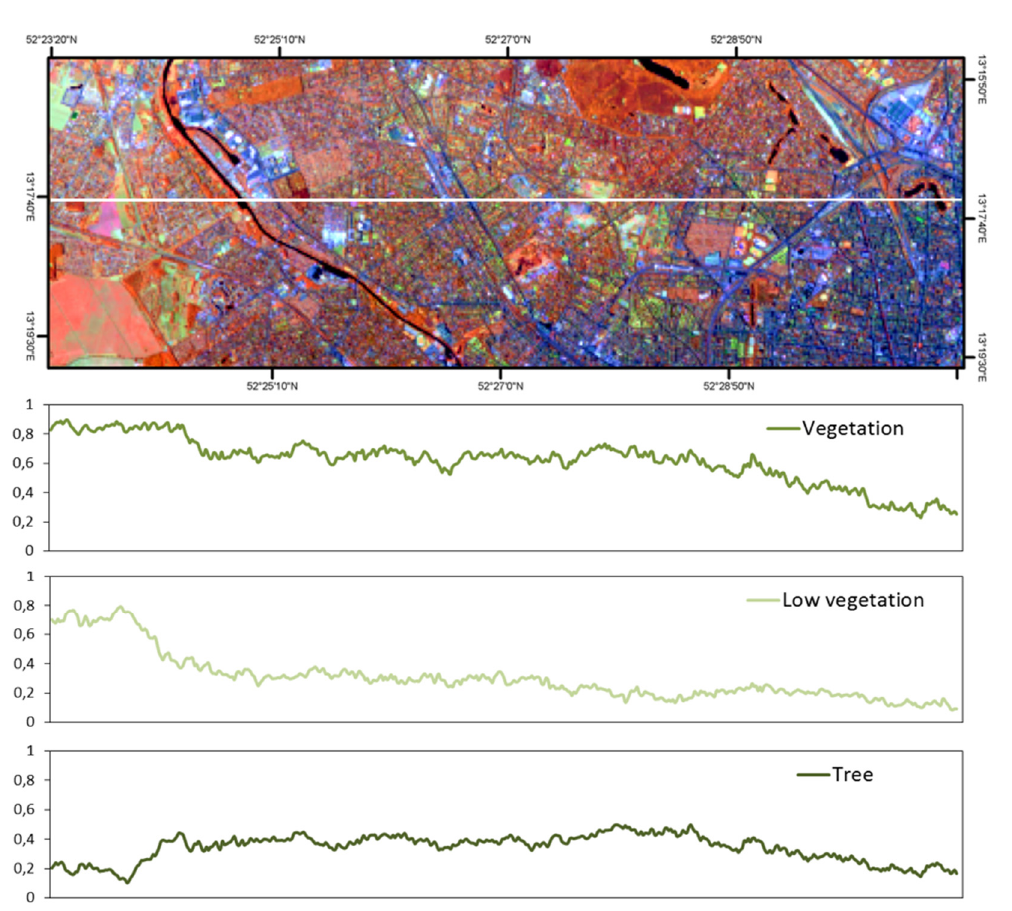
Figure 1. Gradient of vegetation cover fractions along a rural-to-urban transect in Berlin captured by simulated Environmental Mapping and Analysis (EnMAP) data (white line): ( Top ) false-color simulated EnMAP data (Red-Green-Blue: 833, 1652, and 632 nm). ( Bottom ) Different mean (across track) vegetation cover fractions along the transect (for further details on the vegetation fraction mapping see